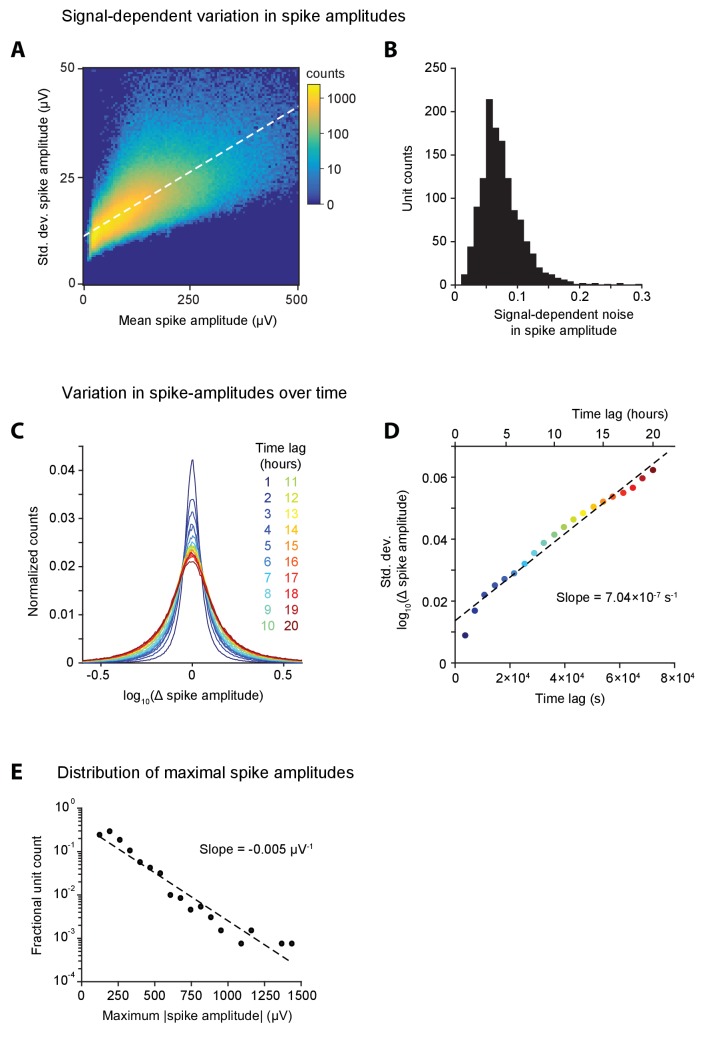
Analyzing long-term recordings in the DLS and MC to characterize variation in unit spike amplitude.(A) Density plot of standard deviation of spike-amplitude versus mean spike amplitude computed in 1 hr blocks for all units in our DLS and MC datasets. Color scale indicates log counts. The slope of the white, dashed line of best fit represents the average signal-dependent variation in spike amplitude for the dataset (slope = 0.06). (B) Histogram of signal-dependent variation in spike amplitudes computed, as shown in A, separately for each unit in our dataset. (C) Each trace is a histogram of the difference in spike amplitudes over time-lags of 1 through 20 hr, colored as per legend, for all units in the dataset. The x-axis is plotted on a log-scale. (D) Standard deviation of histograms of log spike-amplitude differences over different time-lags from 1 to 20 hr, as shown in C. Dashed line indicates line of best fit. (E) Distribution of maximum spike amplitudes for all units in our dataset that we had recorded for at least 50 hr. The y-axis represents fractional unit counts on a log-scale. Dashed line indicates line of best fit whose slope characterizes the exponential fall-off in the fraction of units with increasing large spike amplitudes.